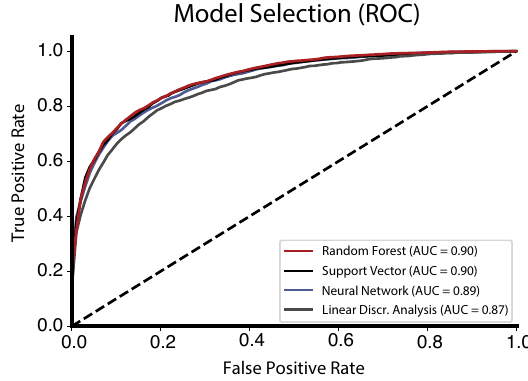
Figure 6. Comparison of the ROC curves (and the associated AUC metric) among the tested machine learning algorithms.